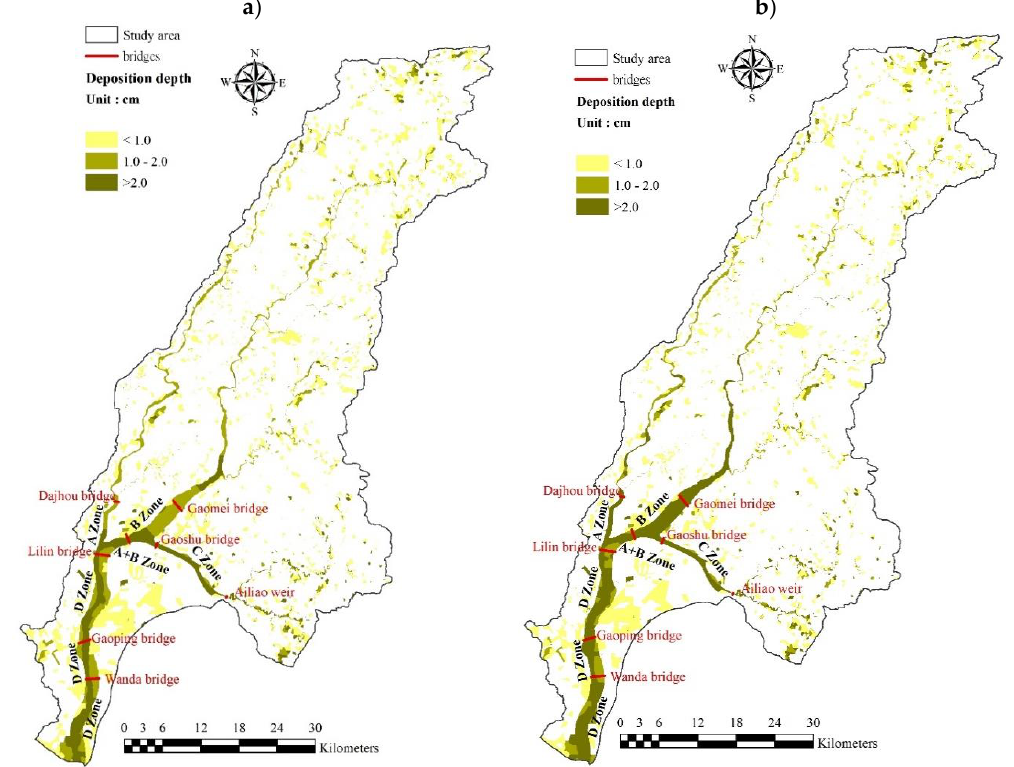
Figure 18. Deposition depth distribution under 100 year return period for ( a ) baseline and ( b ) climate change scenarios.